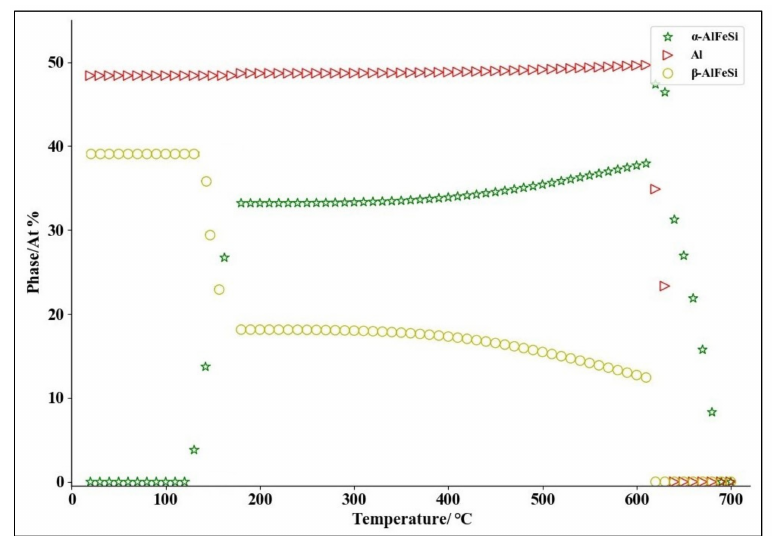
Figure 2. The temperature-phase transition characteristics of α -AlFeSi and β -AlFeSi from